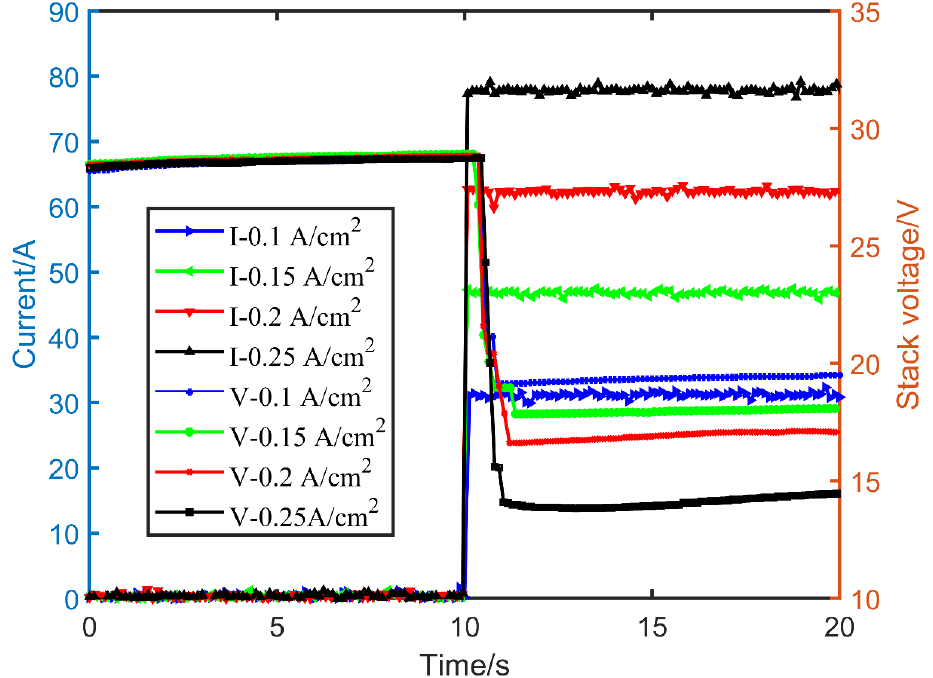
Figure 2. Evolution of different step current variations and corresponding stack voltage outputs.